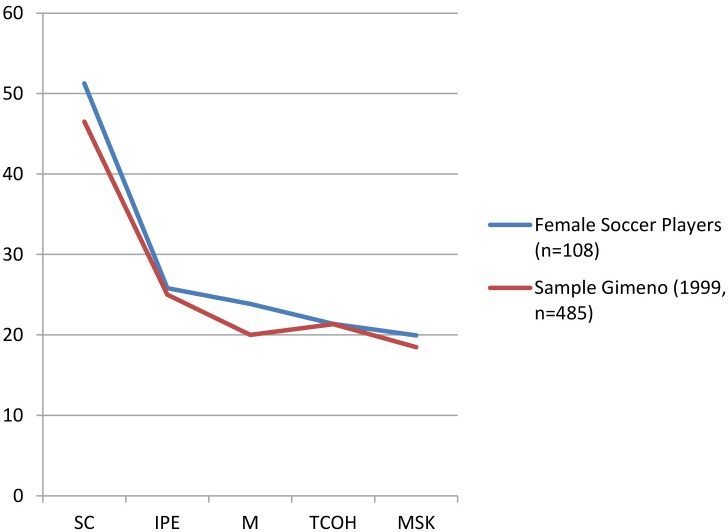
Comparative graph between the average scores of a general sample of athletes (Gimeno, 1999), and the scores of female soccer players in the present study.